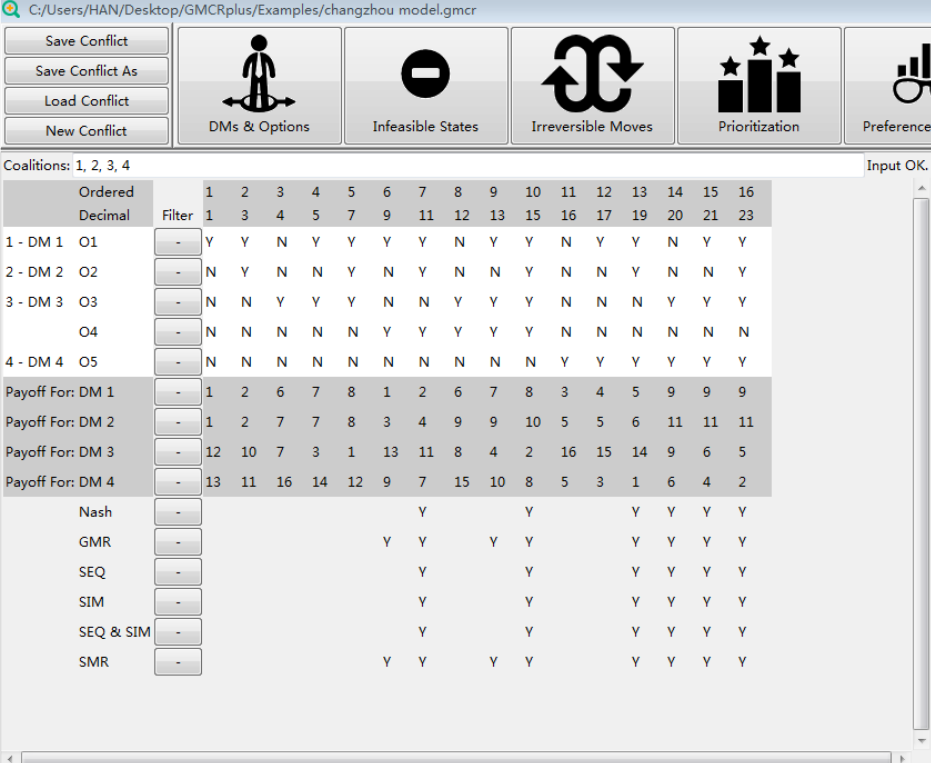
Figure 11. Stability